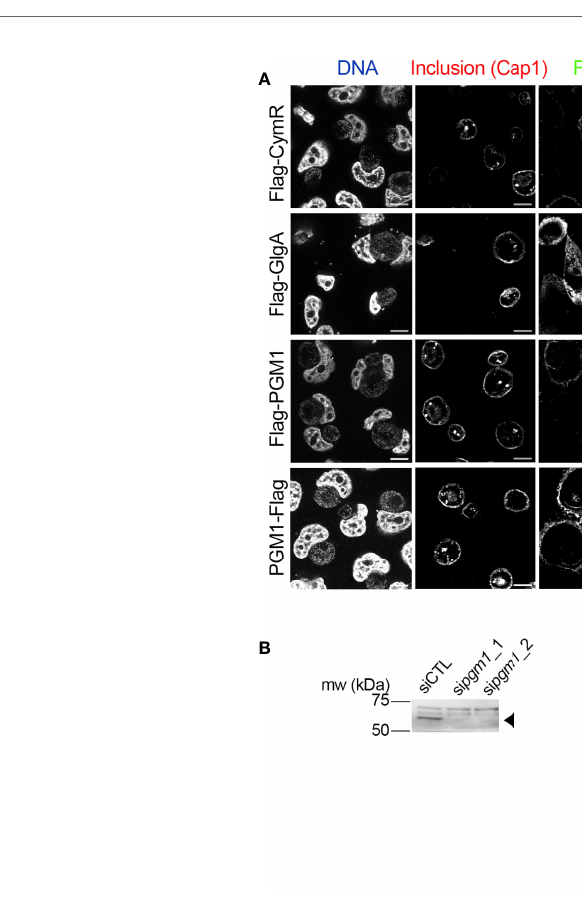
FIGURE 1 | Host PGM1 does not accumulate in the inclusion lumen and is dispensable for C. trachomatis development. (A) – HeLa cells were transfected with the indicated Flag-tagged constructs, infected with C. trachomatis L2 and fi xed 24 h later. Cells were permeabilized and stained for the inclusion membrane protein Cap1 (red) and Flag (green). DNA was stained with Hoechst (blue). The merge image is shown. An enlargement of the boxed area is displayed on the right. Only Flag-GlgA was consistently detected in the inclusion lumen (arrowheads). Bar is 10 m m. (B) – Two different siRNA were used to silence pgm1 expression and the effect on PGM1 level was measured by western blot. The arrowhead points to PGM1 (mw=61.5 kDa), higher bands are nonspeci fi c. (C) – The effect of pgm1 silencing on bacterial progeny was measured 48 hpi. Dot plot distribution of the progeny for three independent experiments is shown. Gray bar, median. Statistical signi fi cance was calculated using two-way analysis of variance (ANOVA) with Dunnett ’ s multiple comparison test and was not signi fi cant